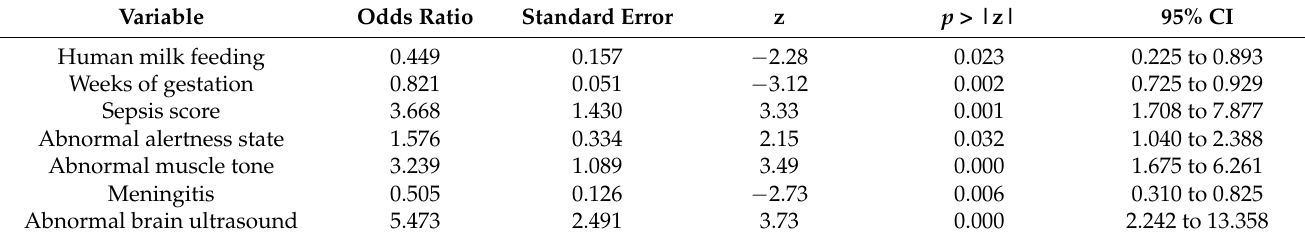
Table 3. Multivariate logistic regression analysis of factors associated with higher respiratory